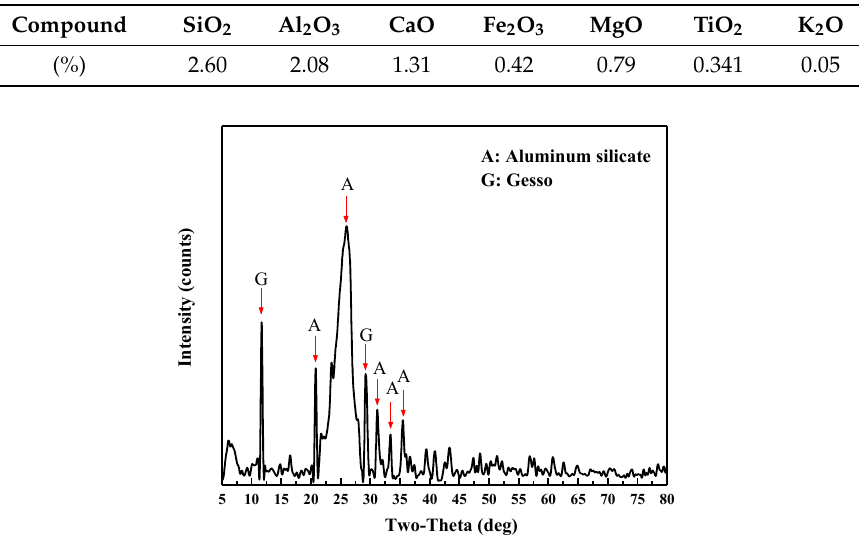
Figure 2. X-ray diffraction (XRD) spectra of the coke powder used in this study. Figure 2. X-ray di ff raction (XRD) spectra of the coke powder used in this